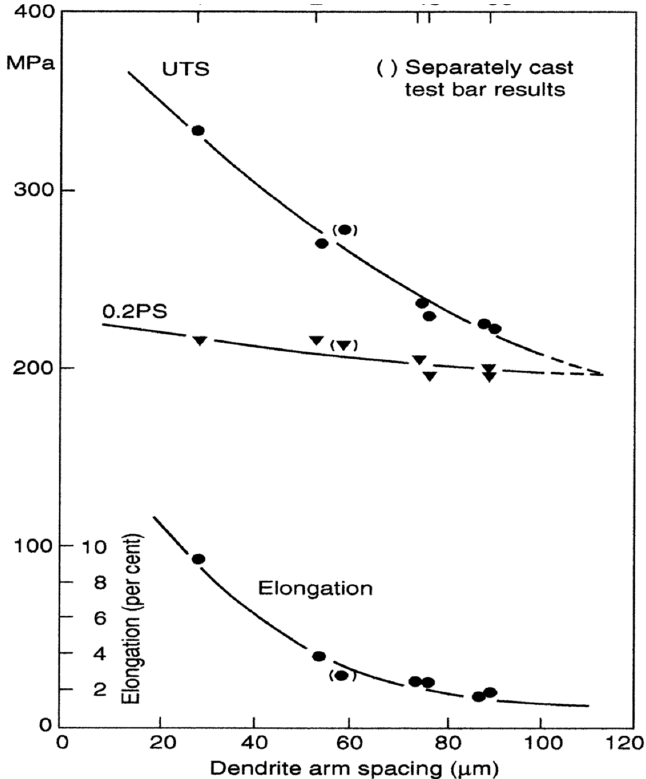
Figure 2. The effect of DAS on tensile properties for Al–7Si–0.4Mg alloy [7].